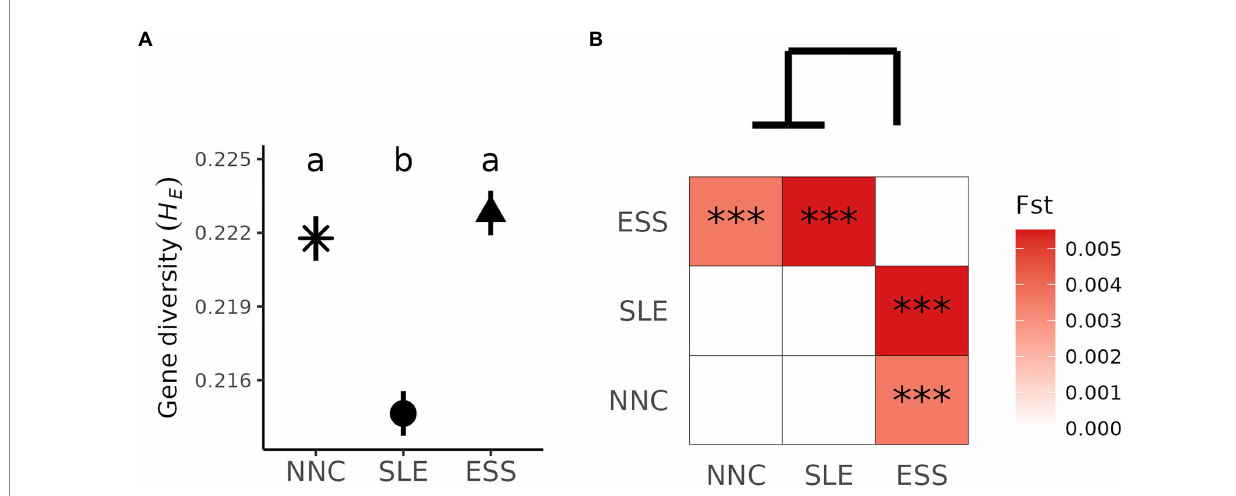
FIGURE 4 Pandalus borealis genetic variation. (A) Within origin genetic variation. Mean and standard error of gene diversity ( H E ) for each origin. The result of Tukey HSD (honest significant difference) post hoc tests are displayed as letters, with different letters representing significant differences among origins’ mean values ( p < 0.001). (B) Among origins genetic variation. Pairwise genetic differentiation ( F ST ) among shrimp’s origin varied from white (zero) to red (high), as shown on the right-hand side of the heat-map and values significantly different from zero are denoted by *** for p < 0.001. The dendrogram on the top resulted from hierarchical cluster analysis based on the pairwise F ST . ESS = Eastern Scotian Shelf, SLE = St. Lawrence Estuary, NNC = Northeast Newfoundland Coast.